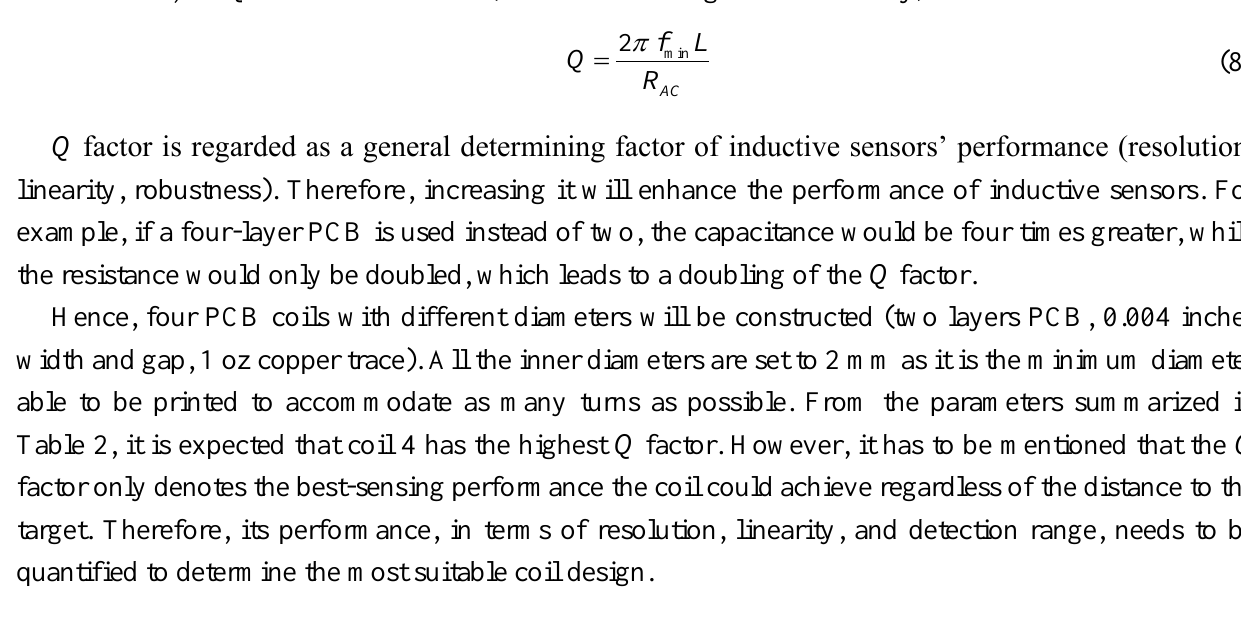
Table 2. Inductive parameters of four designed PCB